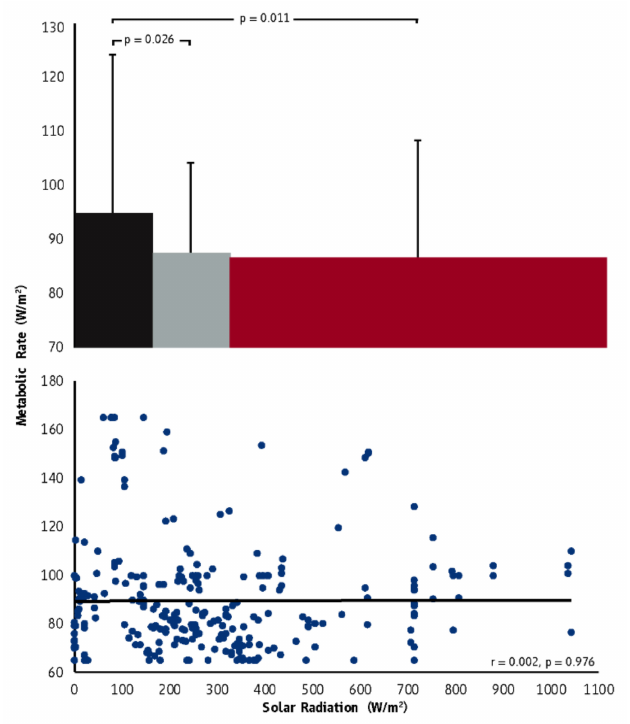
Figure A3. The average ( ± SD) metabolic rate in indoor (black), mixed (grey), and outdoor (red) environments characterized by the same thermal stress (top graph) as well as the association between hourly metabolic rate and solar radiation (bottom graph). Bar width in the top graph indicates the range of solar radiation of each category corresponding to the horizontal axis, while horizontal brackets indicate statistically significant